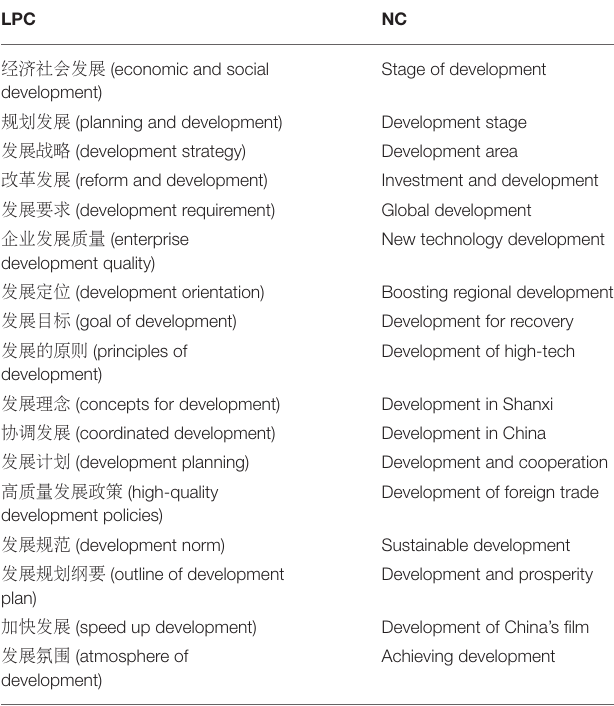
TABLE 10 | Collocations of “development” in the two